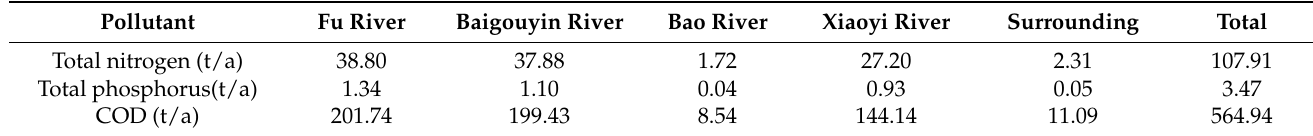
Table 3. Non-point source pollution load of